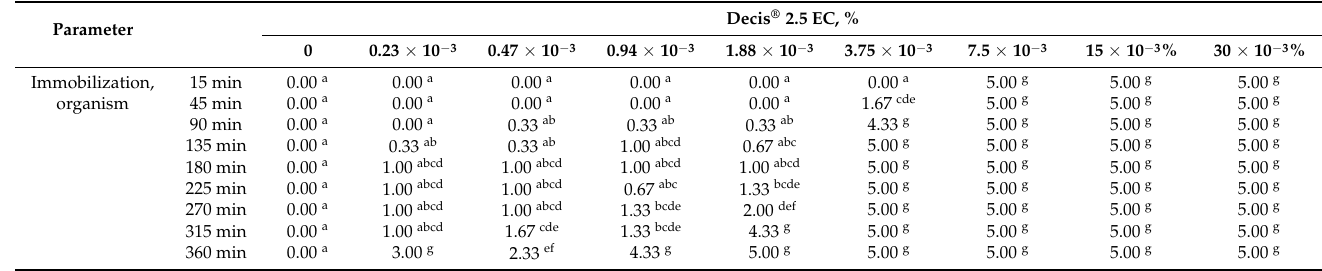
Figure 1. Immobilization of daphnia ( Daphnia magna ) exposed to Decis ® 2.5 EC concentrations (0%; 0.23 × 10 − 3 %; 0.47 × 10 − 3 %; 0.94 × 10 − 3 %; 1.88 × 10 − 3 %; 3.75 × 10 − 3 %; 7.5 × 10 − 3 %; 15 × 10 − 3 %; and 30 × 10 − 3 %). Data points represent the mean ± SD, n = 6. Table 2. The immobilization of Daphnia magna exposed to Decis ® 2.5 EC. The table contains the mean of the examined features and in superscript the level of significance